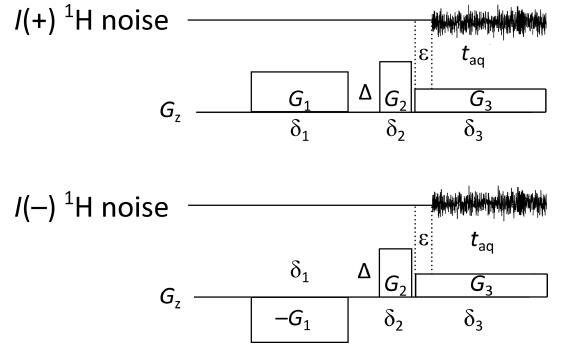
Figure 3. The three-gradient spin-noise-detected diffusion exper- iment. The gradient ratios are adjusted according to Eq. (2). Gra- dients G 2 and G 3 are separated by a short switching delay of 2– 5µs. Typical values in three-gradient sequences for diffusion (e.g., Fig. 5) and relaxation (e.g., Fig. 6) experiments are δ 1 = 2, (cid:49) = 0 . 1, δ 2 = 1ms, a gradient stabilization delay (cid:15) = 0 . 05ms, and an acqui- sition time t aq = 3 . 69ms. The acquisition is run during the third gradient pulse.